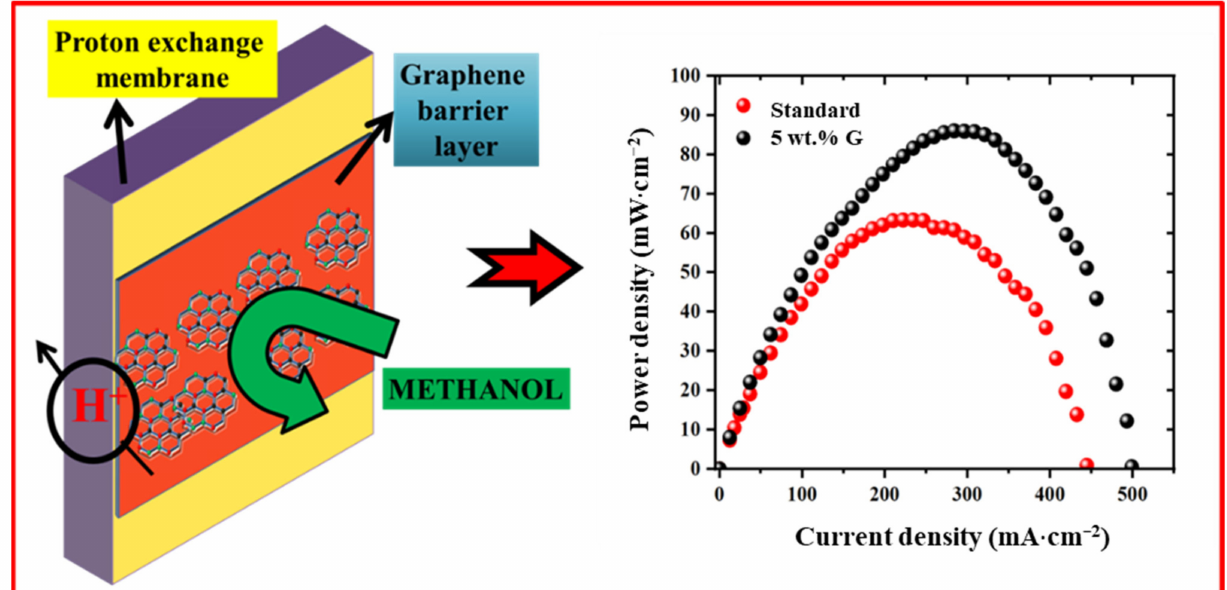
Figure 10. Schematic of impact of addition of graphene nano-layer in membrane region (above the anode catalyst layer) and final fuel cell